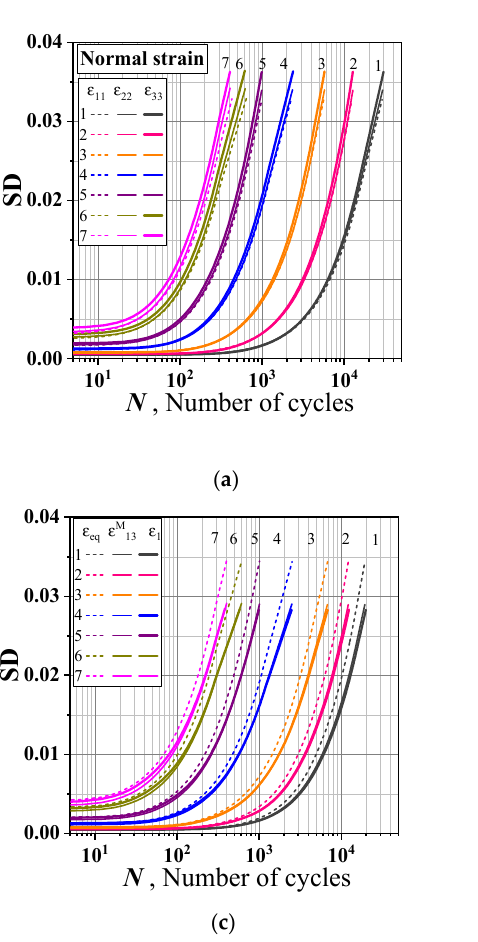
Figure 5. The curves of SDs under different strain amplitude vs. cycle number: ( a ) for normal strains ˆ ε 11 ( E a , N ) , ˆ ε 22 ( E a , N ) and ˆ ε 33 ( E a , N ) ; ( b ) for shear strains ˆ ε 12 ( E a , N ) , ˆ ε 13 ( E a , N ) and ˆ ε 23 ( E a , N ) ; ( c ) for effective strain ˆ ε eq ( E a , N ) , first principal strain ˆ ε 1 ( E a , N ) and maximum principal shear strain ( E a , N ) ˆ ε M 13